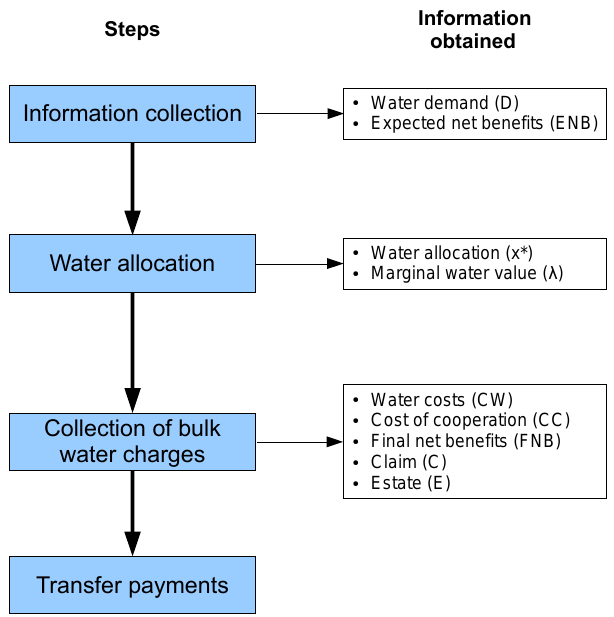
Figure 4. Flowchart of methodology including information ob- tained at each